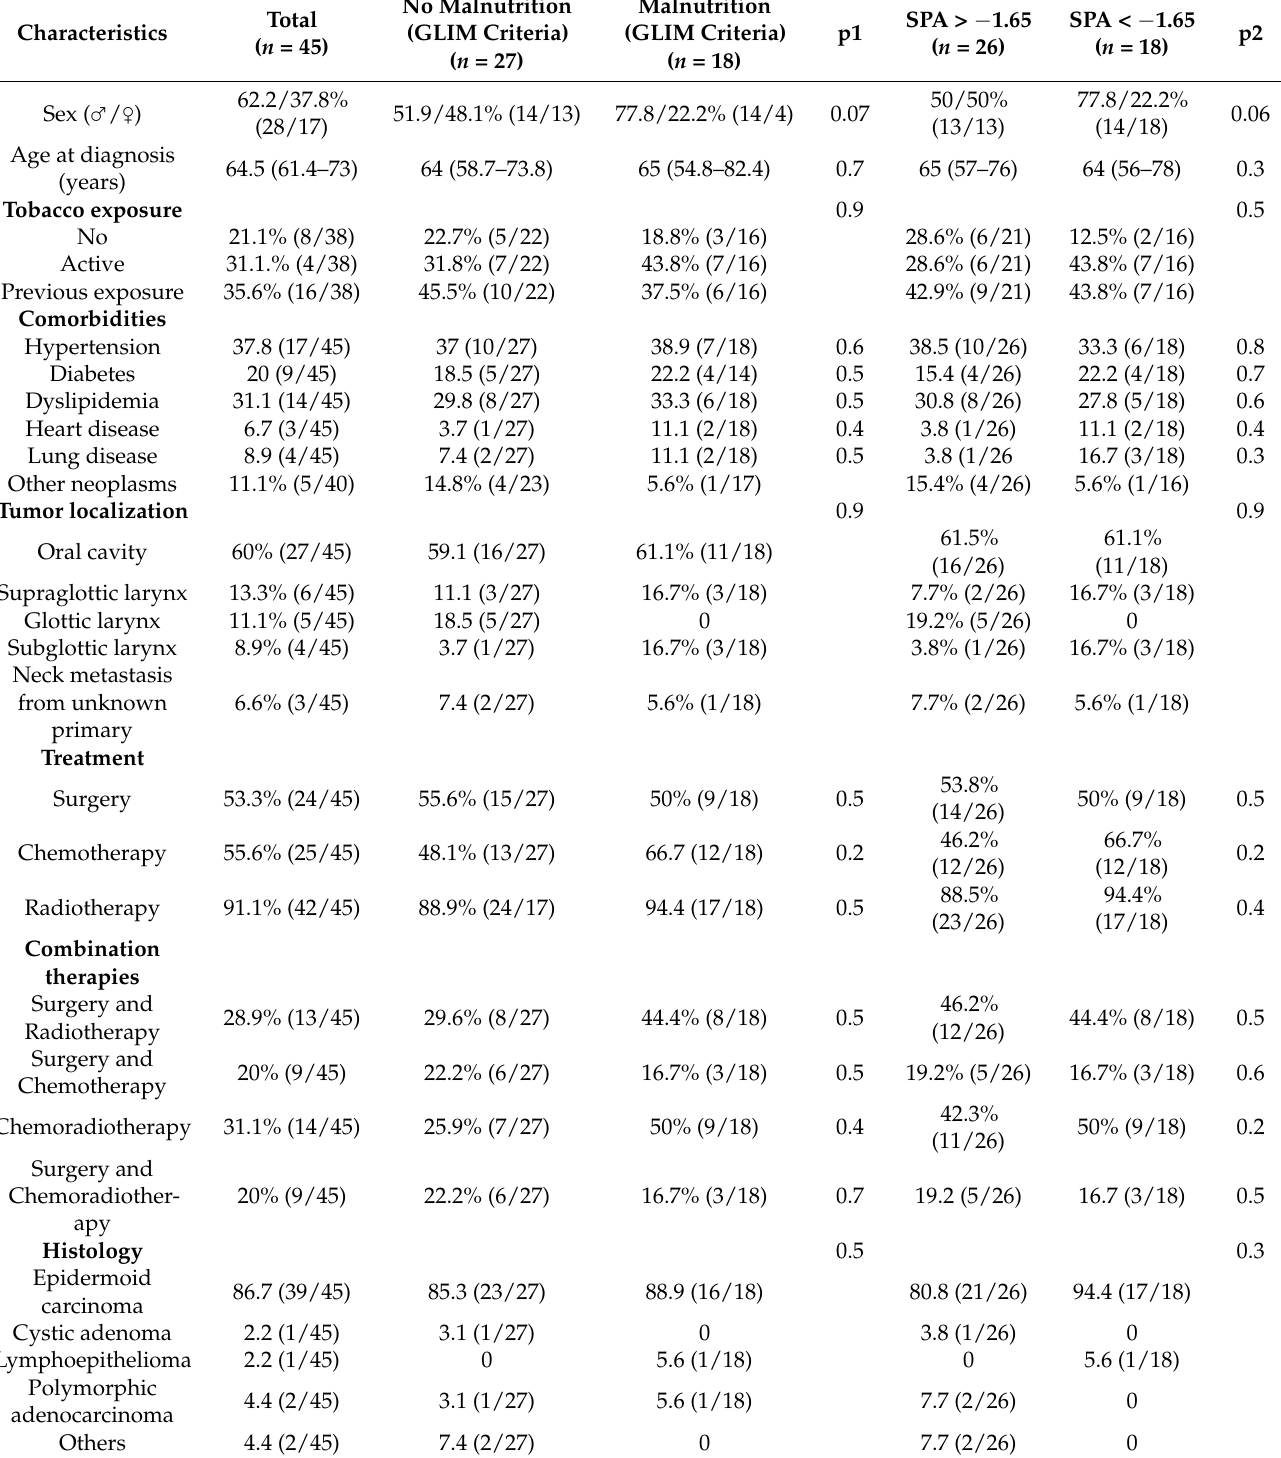
Table 1. Baseline clinical characteristics of the patients. Comparison between groups based on the presence of malnutrition according to the Global Leadership Initiative on Malnutrition (GLIM) criteria or a standardized phase angle < −